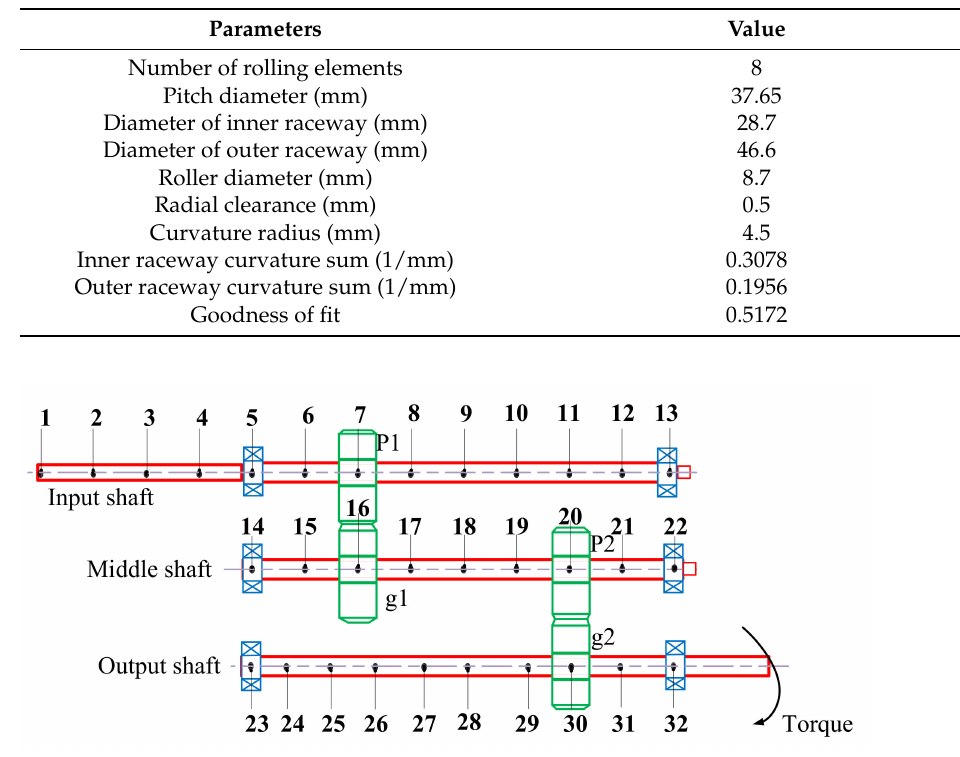
Table 5. Bearing parameters of system.